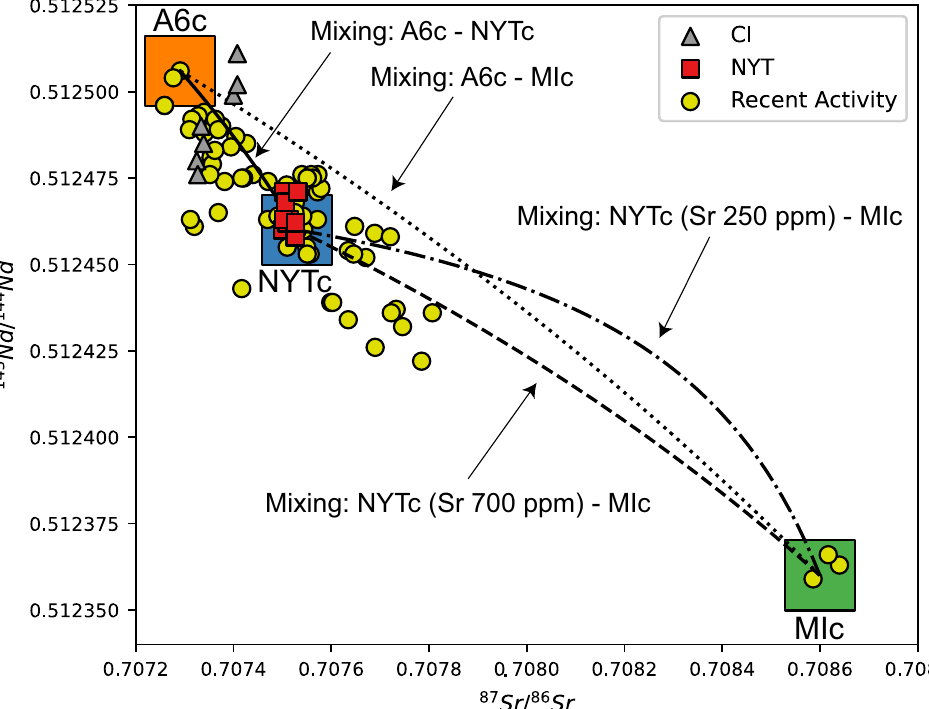
Fig. 2 Representation of the three main magmatic components (big squares) and mixing models (lines) as defined by Di Renzo et al. 2011. CI component as defined by D’Antonio et al. 1999 is not reported as end-member, but it can be individuated by the clustering of triangle datapoints. Lines were obtained using a binary mixing model by the hyperbolic equation Ax between the NYTc and Mic consider different Sr concentrations for the NYTc, i.e., 250 and 700 ppm, respectively. Error bars are smaller than datapoints. Modified after Arienzo et al.